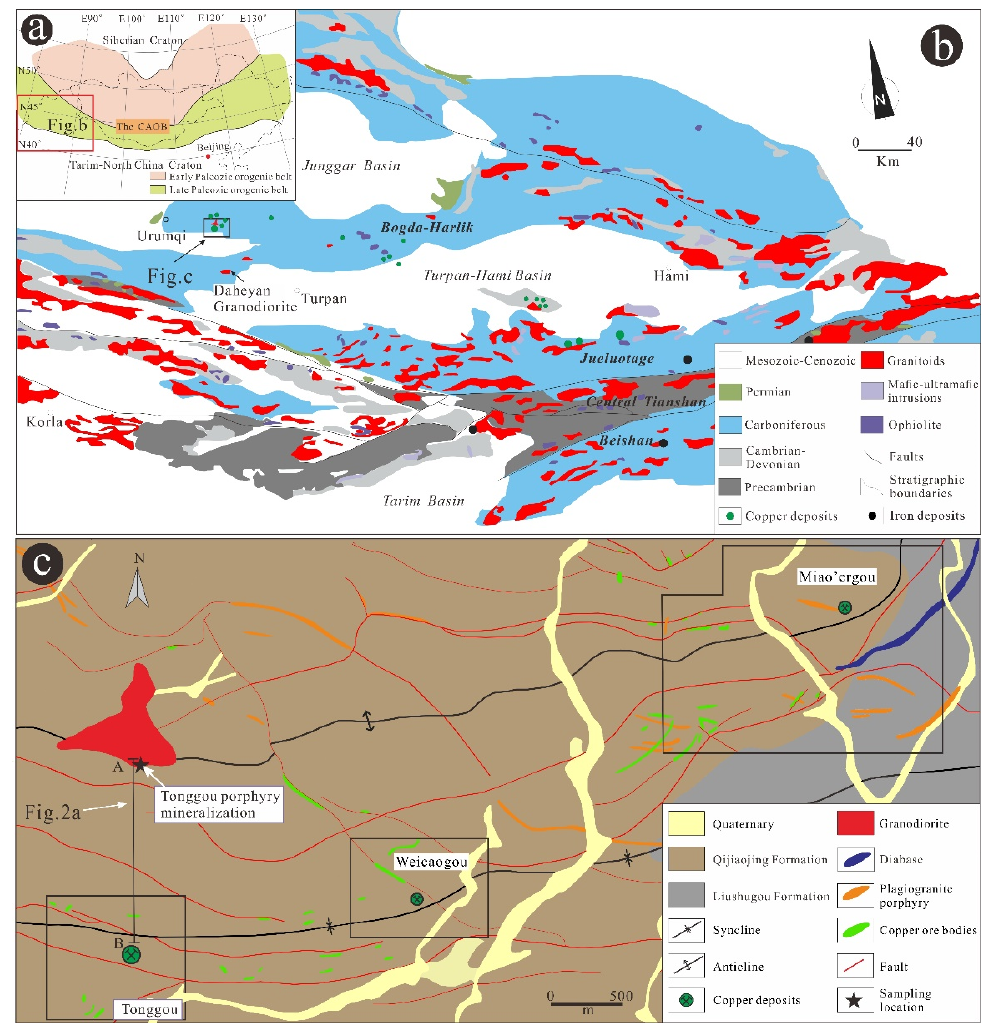
Figure 1. ( a ) Schematic geologic map of the Central Asian Orogenic Belt (CAOB); ( b ) geological map of Eastern Tianshan [15]; ( c ) geological map of the mineralized district in the Tonggou-Miao’ergou area (modified after [20]).